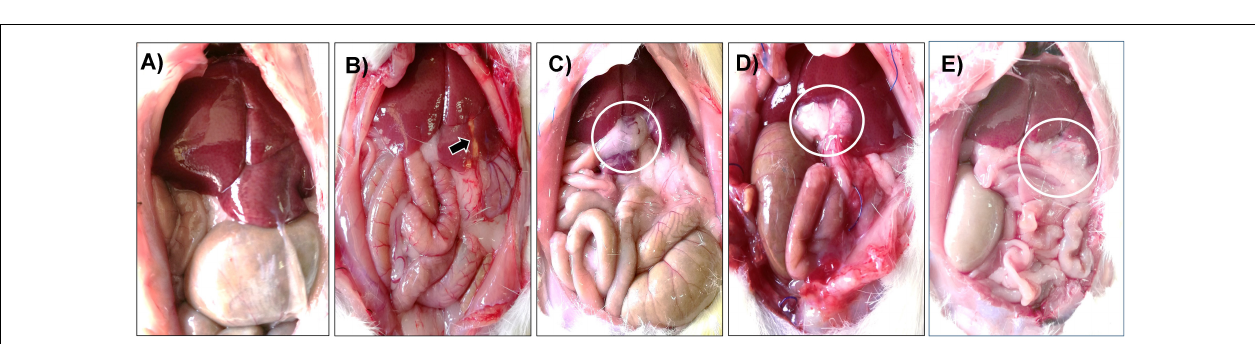
FIGURE 1 | Animal groups. (A) Rats without hepatectomy (sham). Right inset, normal hepatic parenchyma. (B) Rats with partial hepatectomy (PH). Triangular dissected basal tissue (inset). (C) Rats with PH + CMS. Normal liver zone (upper inset), regeneration area where the collagen matrix scaffold (CMS) was implanted (lower inset). (D) Timeline with the experimental design.